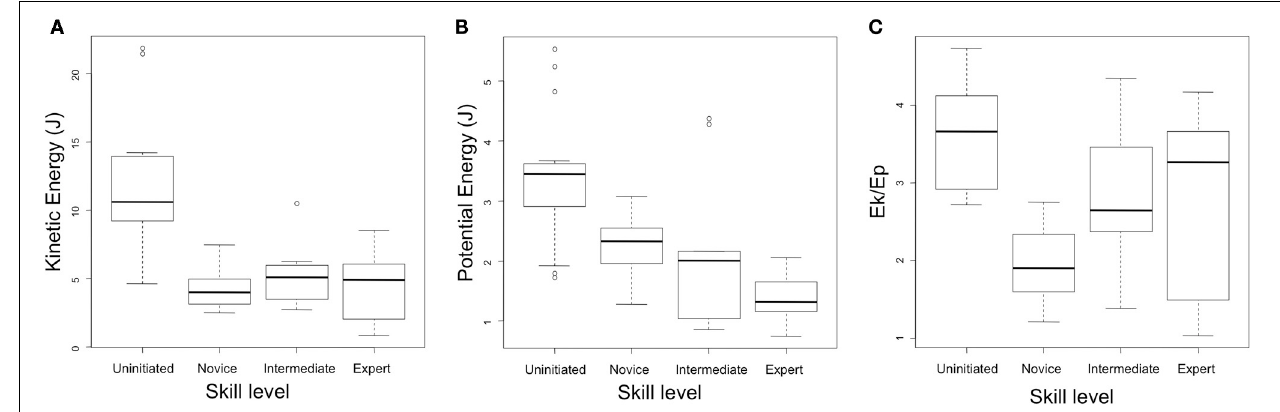
FIGURE 6 | Regulation of functional parameters according to level of expertise. (A) Mean values of maximal kinetic energy of the hammer. (B) Potential energy relative to the striking surface of the core. (C) Ratios of kinetic energy to potential energy. Whisker values indicate the confidence interval at 0.95.